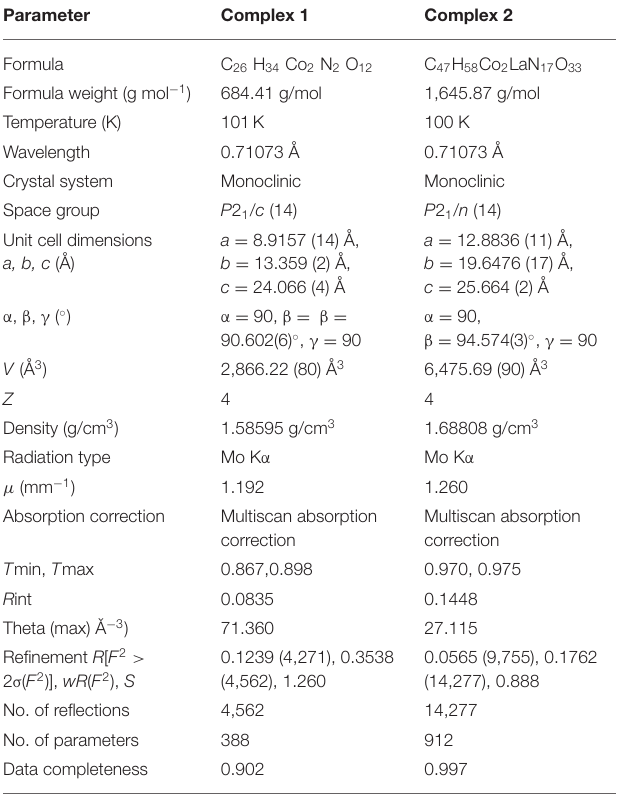
TABLE 1 | Phase data of complexes 1 and